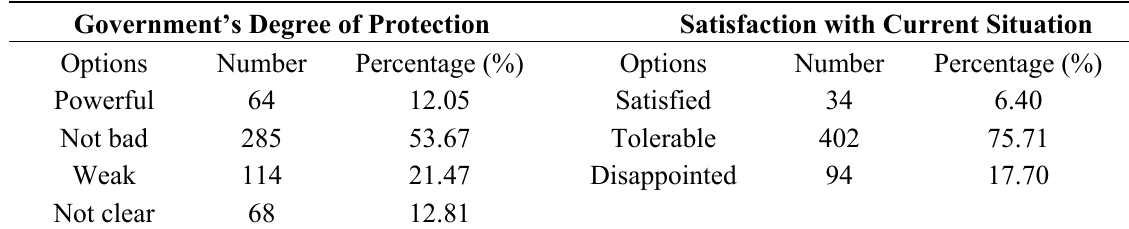
Table 2. Respondents’ attitude of